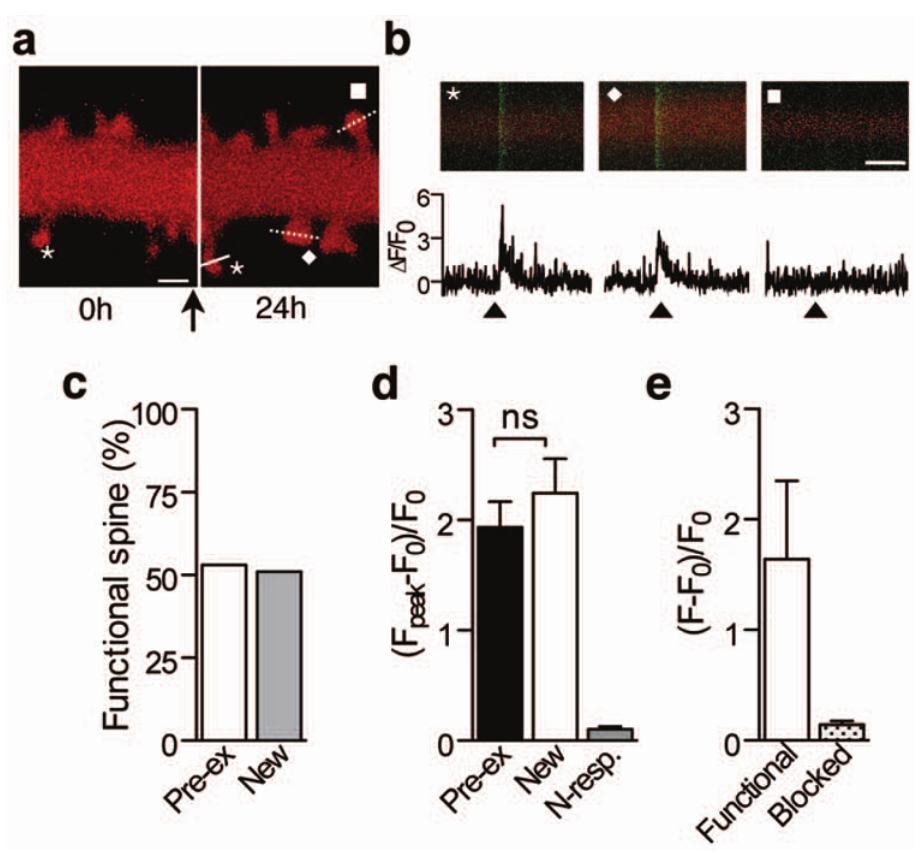
Figure 6. New spines formed following midazolam treatment are functional. ( a ) 3D volume rendering of images of an mRFP transfected and Fluo-4 AM loaded cell showing newly formed spines detected 24 h after midazolam application (arrow). The dashed lines and the plain line indicate where line scan analysis was performed at 24 h for the 2 new spines (square and diamond) and a pre-existing spine (star), respectively. ( b ) Top: line scans of the spines with the corresponding symbols in (a), the red channel showing mRFP fluorescence, and the green channel showing Fluo-4 AM fluorescence. Bottom: Fluo-4 AM corresponding signals expressed as D F/F 0 , illustrating the intracellular calcium response obtained upon electrical stimulation of Schaffer collaterals (arrowhead). ( c ) Percentage of spines that responded to stimulation by an elevation of intracellular free calcium concentration for new (grey) and pre-existing spines (white). ( d ) Mean amplitude of calcium responses ( D F/F 0 measured at the peak of the response triggered by electrical stimulation of Schaffer collaterals) for spines present at the beginning of the experiment (pre-existing spines, n =15 spines in 2 neurons) compared to spines that appeared during of after midazolam treatment (new spines, n =43 in 4 neurons). P =0.65, unpaired t test. N-resp.: calcium signal in non responding spines ( n =23 in 4 neurons). ( e ) Calcium signal of newly formed functional spines before (Functional) and after (Blocked) a half an hour bath application of AP5 (50 m M) and NBQX (20 m M) ( n =8 new spines in 2 cells). Compare to the mean signal recorded for non responding spines in (d). F corresponds to the mean amplitude of the Fluo-4 fluorescence measured during the 20 ms consecutive to the stimulation pulse. Scale bars: (a): 1 m m. (b): 2 s.